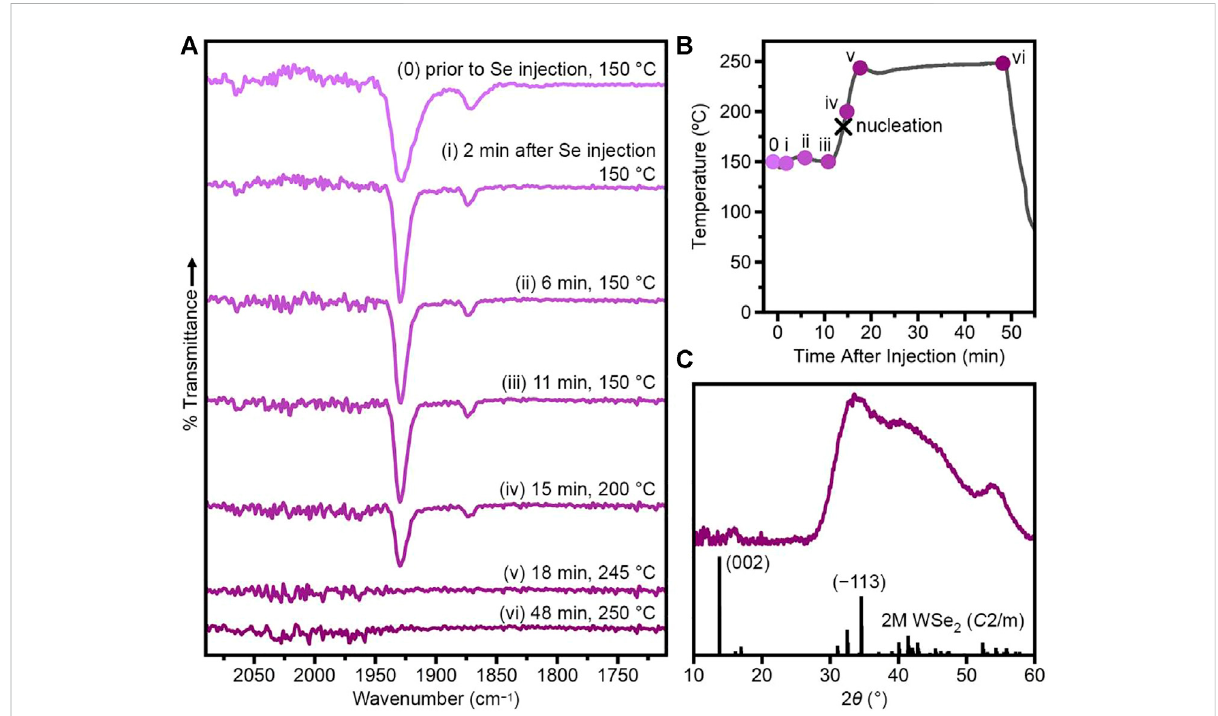
FIGURE 3 Injection of Ph 2 Se 2 into W(CO) 6 + TOPO + TOP (TOPO/TOP/Se/W = 100/1/4/1) at 150 ° C. (A) FTIR spectra of aliquots taken prior to Se injection and approximately 2, 6, 11, 15, 18 and 48 min after Se injection. (B) Temperature pro fi le of the reaction with aliquots indicated by circles. The black x indicatesthenucleationevent,evidencedbyacolor-changeofthereactionsolution. (C) PowderX-raydiffractionpatternofnanocrystallineproduct compared to that simulated from single-crystal data for 2M WSe 2 (Fang et al.,